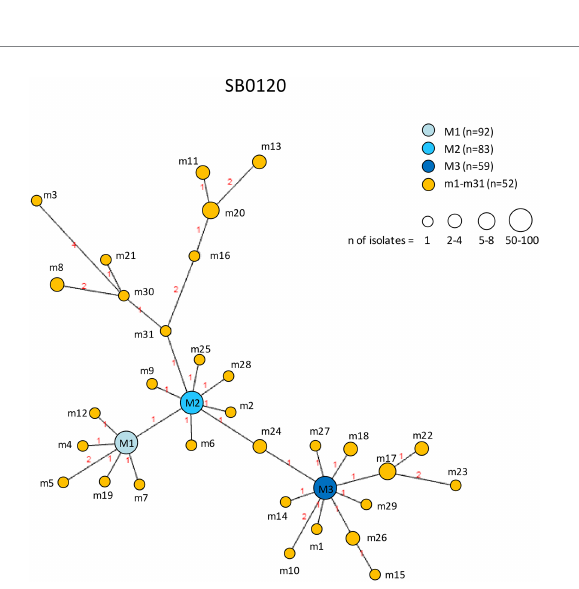
FIGURE 9 Minimum spanning tree of Mycobacterium bovis isolates belonging to spoligotype SB0120. The number of isolates ( n ) is indicated in the legend, in parentheses. Each circle represents a distinct 12-locus MIRU-VNTR code. The color of the circle represents a profile, as indicated in the legend: each of the major profiles has been assigned a shade of blue, whereas all minor profiles are shown in orange. The size of the circles is proportional to the number of isolates. Branch lengths correspond to the number of locus differences. Link labels refer to the distance matrix. The tree is based on PHYLOViZ